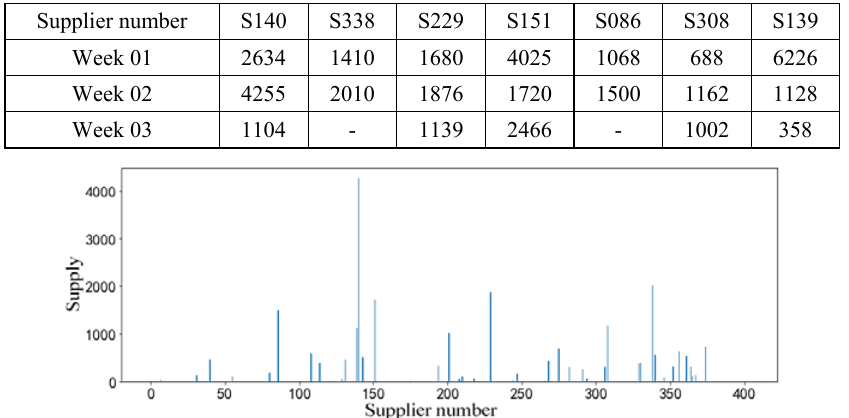
Fig. 4. Selection of suppliers and supply